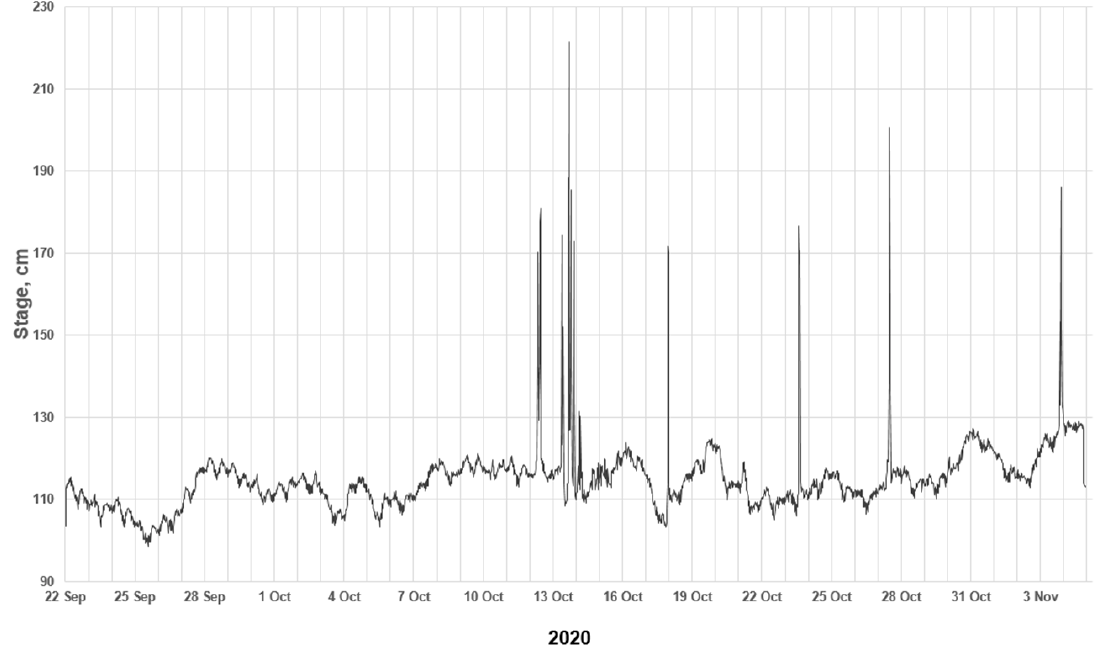
Figure 6. Wastewater hydrograph (22 September to 5 November 2020) perturbated by storm events at Akademija–Marvele (A = 1.5 km 2 , PE = 2400).